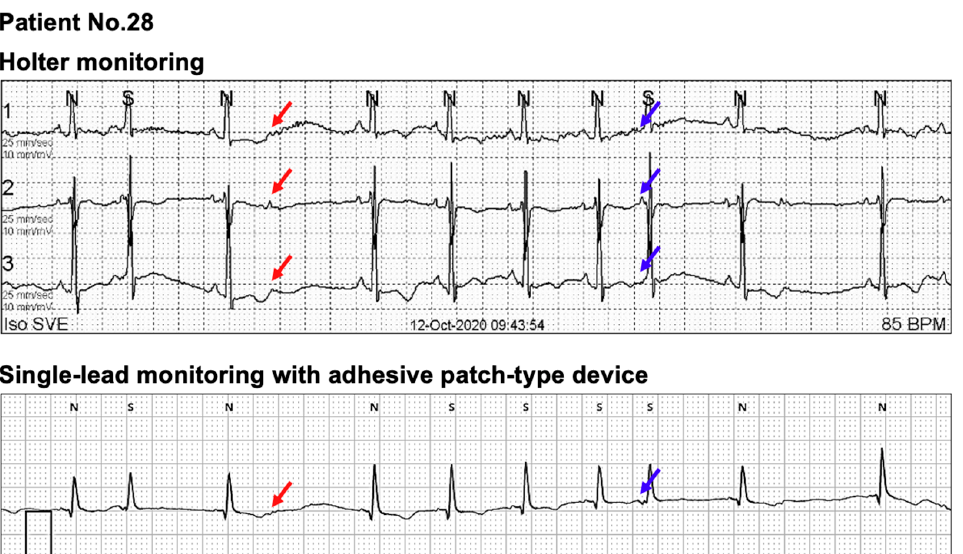
Figure 4. An exemplary case of reporting more VEBs with a single-lead ECG monitoring than with Holter monitoring. The participant had PACs with aberrant conduction (red arrows) in Holter monitoring. However, the aberrant conduction was less clear in this participant because the P-waves are unclear in the single-lead ECG monitoring. Therefore, for the patients with P-waves of low amplitude, a compensatory pause should be considered in addition to the change in QRS morphology when judging a premature ventricular complex or aberrant conduction with the single-lead ECG monitoring. Abbreviations: ECG, electrocardiogram; PAC, premature atrial complex; VEB, ventricular ectopic beat.